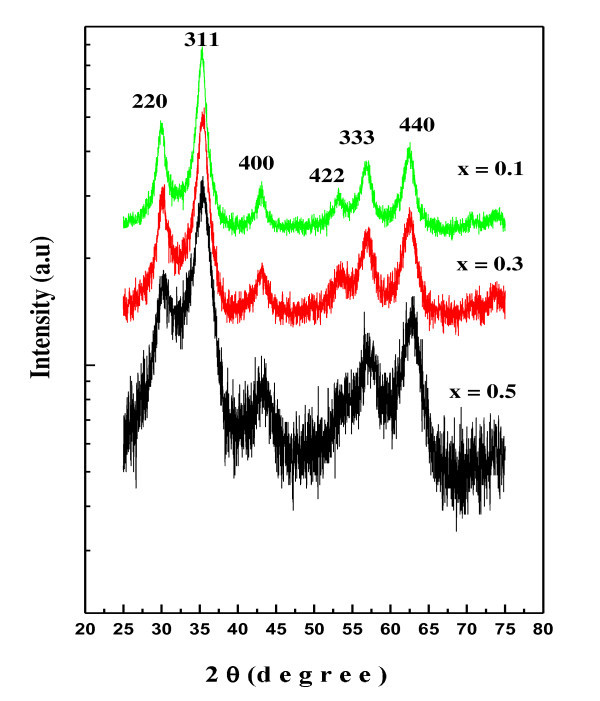
X-ray diffraction pattern of Ni0.2Cd0.3Fe2.5 - xAlxO4 (0.0 ≤ x ≤ 0.5) ferrite nanoparticles.